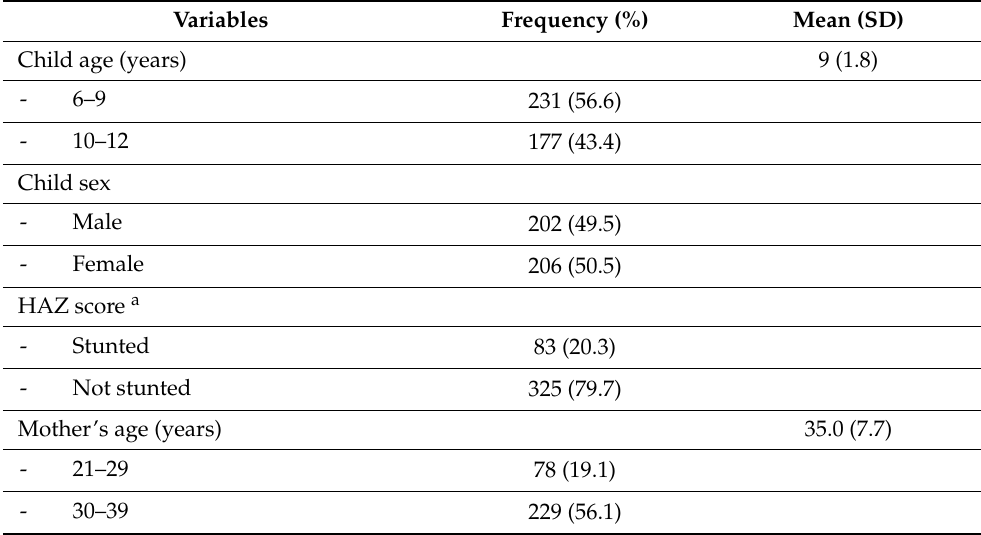
Table 1. Socio economic characteristics and food consumption patterns of respondents and children ( n =